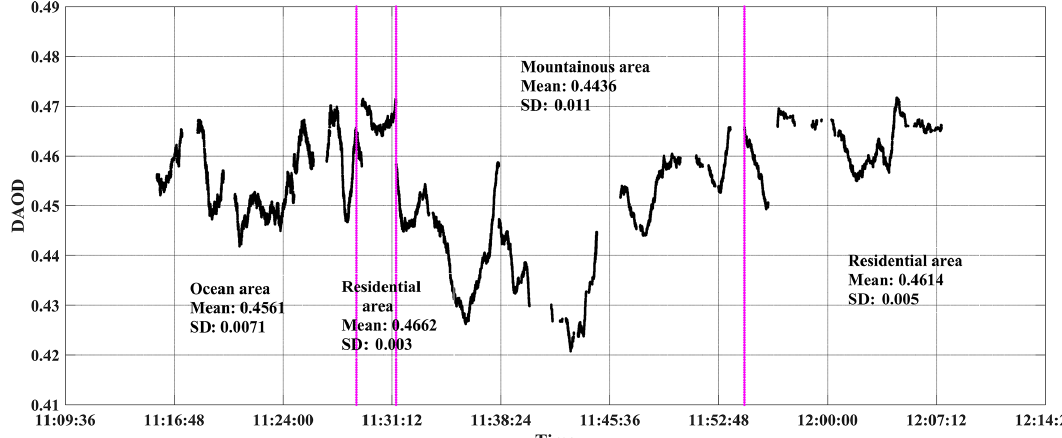
Figure 10. DAOD results over ocean areas, urban residential areas and mountain areas on 14 March 2019. The purplish red vertical line represents the boundary of different surface types. The plane passes through the ocean area, urban residential area, mountain area, and urban residential area in turn, which is the same in the following results.